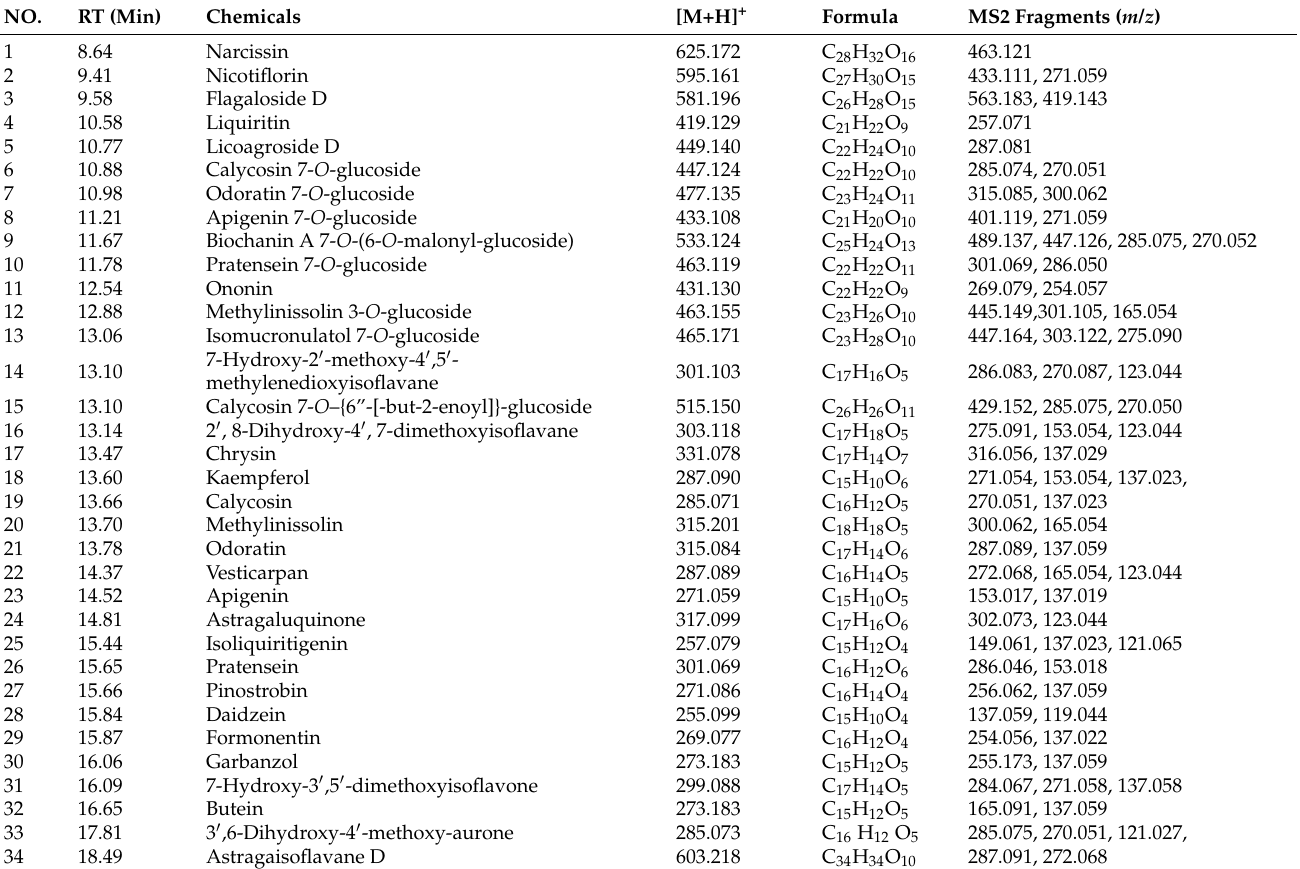
Table 1. The identified flavonoids compounds of Astragalus based on the UHPLC-ESI-MS/MS method.